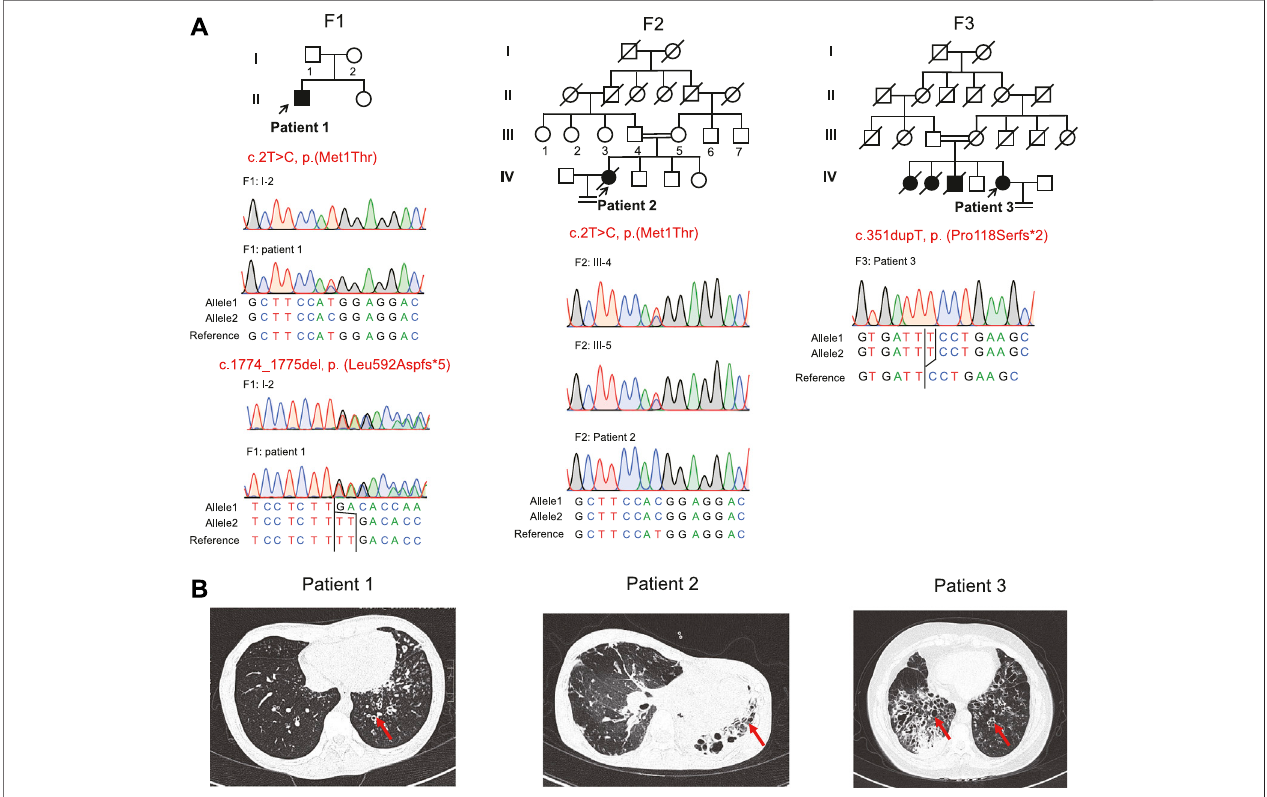
FIGURE 1 | Pedigrees, variants, and clinical features of these patients. (A) Pedigrees of three families (F1, F2, and F3) with RSPH4A variants and the segregation analysis by Sanger sequencing. The fi lled symbol represents the affected member, the empty symbol represents unaffected members, and the slashed symbols representdeceasedmembers.Squares,males;circles,females.Thepatients(patient1,patient2,andpatient3)includedinthisstudyareindicatedbyablackarrow. (B) Chest high-resolution computed tomography showed bronchiectasis (red arrows) in these patients.